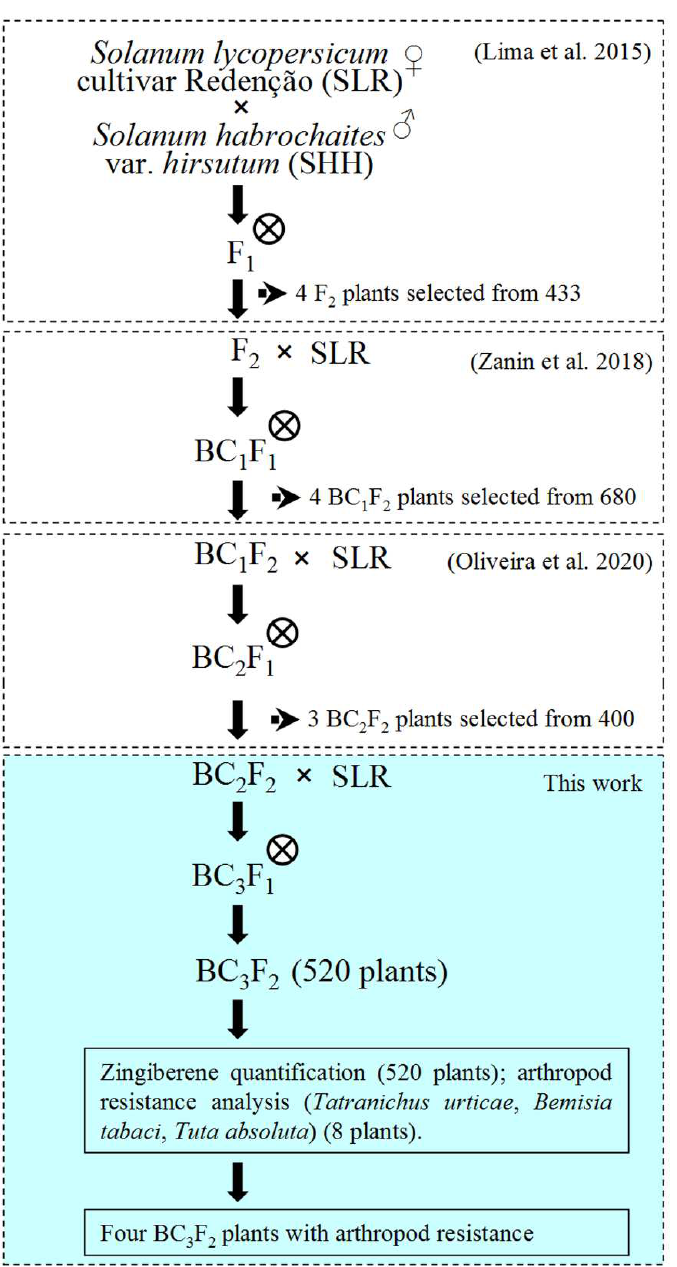
Figure 1. Crossing and backcrossing stages used in the program to select pest tolerant genotypes with high zingiberene content